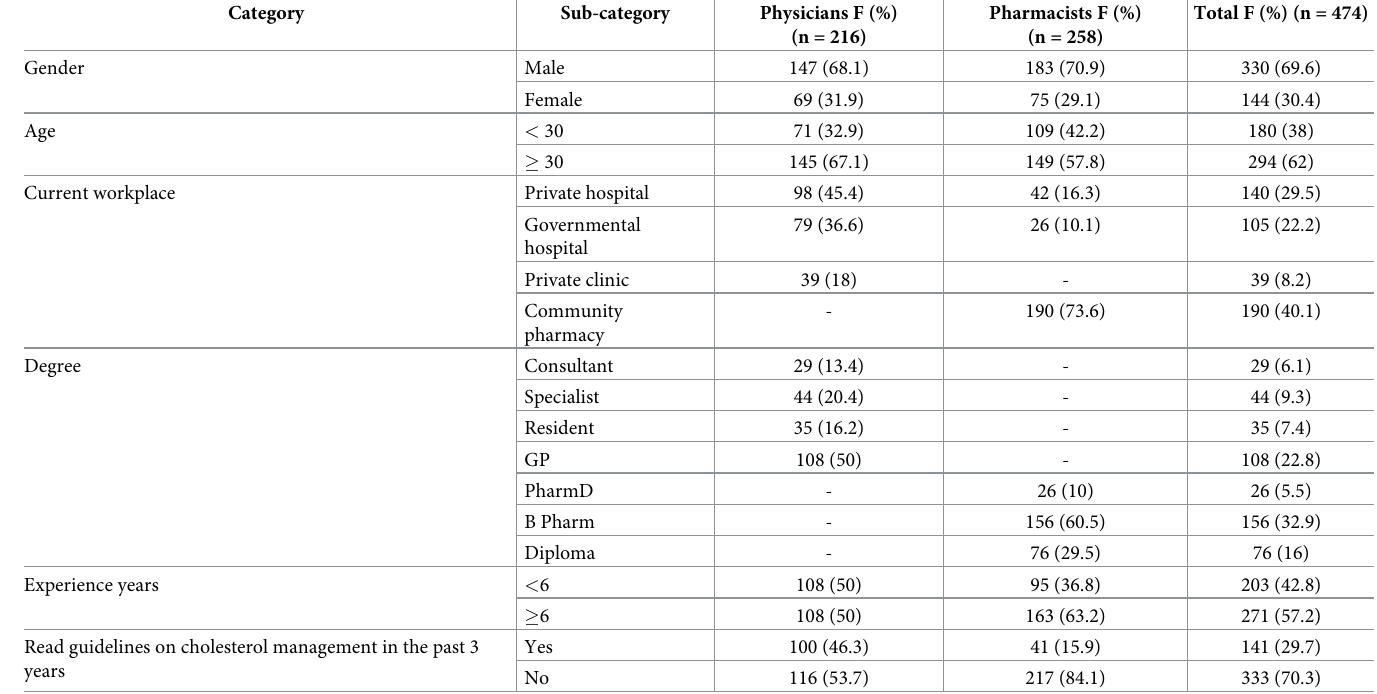
Table 1. Demographic characteristics (n =